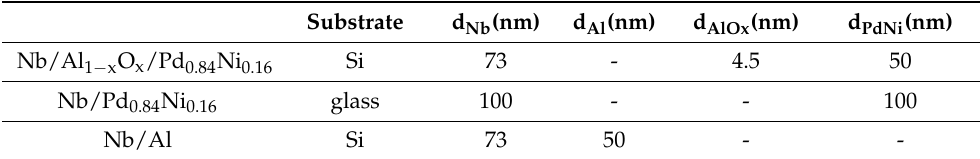
Table 1. Characteristics of the samples.